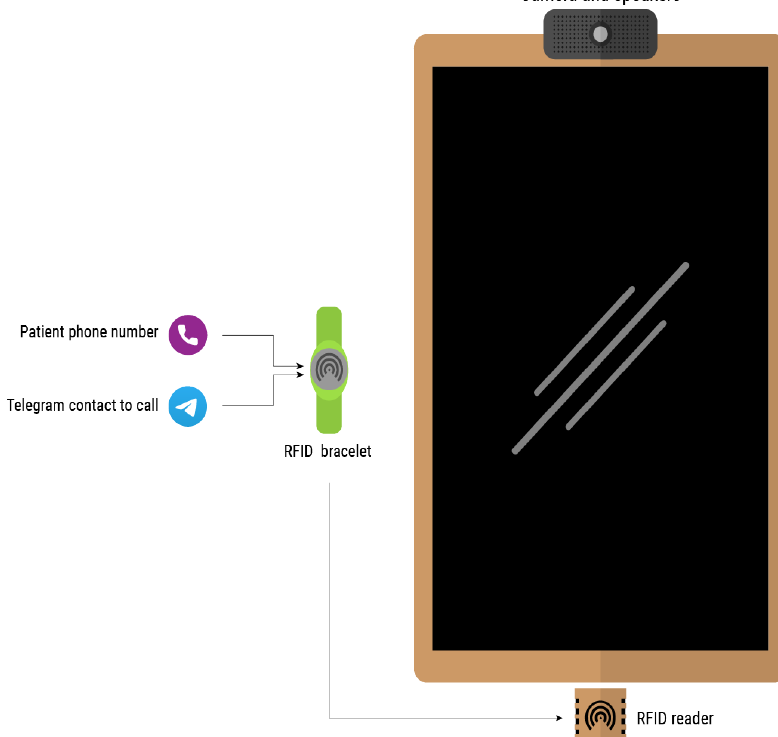
Figure 5. Elements intervening in the call